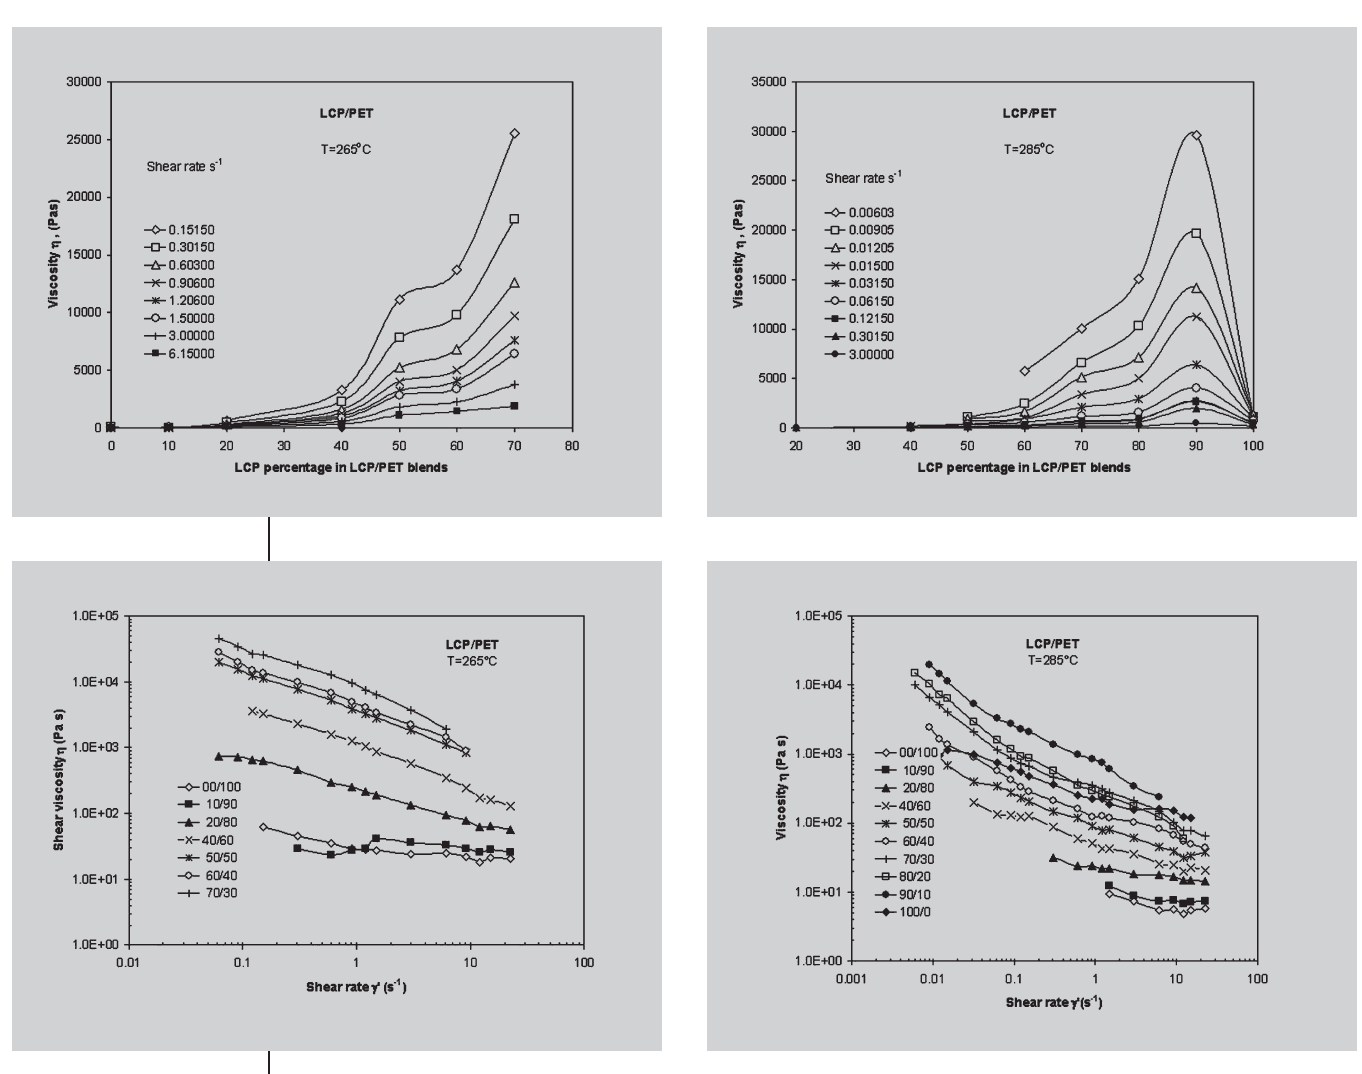
Figure 1 (left above): Plots between the viscosity of LCP/PET blend and the composition of blends at different shear rates at 265°C. Figure 2 (right above): Plots between the viscosity of LCP/PET blend and the composition of blends at different shear rates at 285°C. Figure 3 (left below): Plots between viscosity and shear rate for various blends of LCP and PET along with the data of PET at 265°C. Figure 4 (right below): Plots between viscosity and shear rate for various blends of LCP and PET at